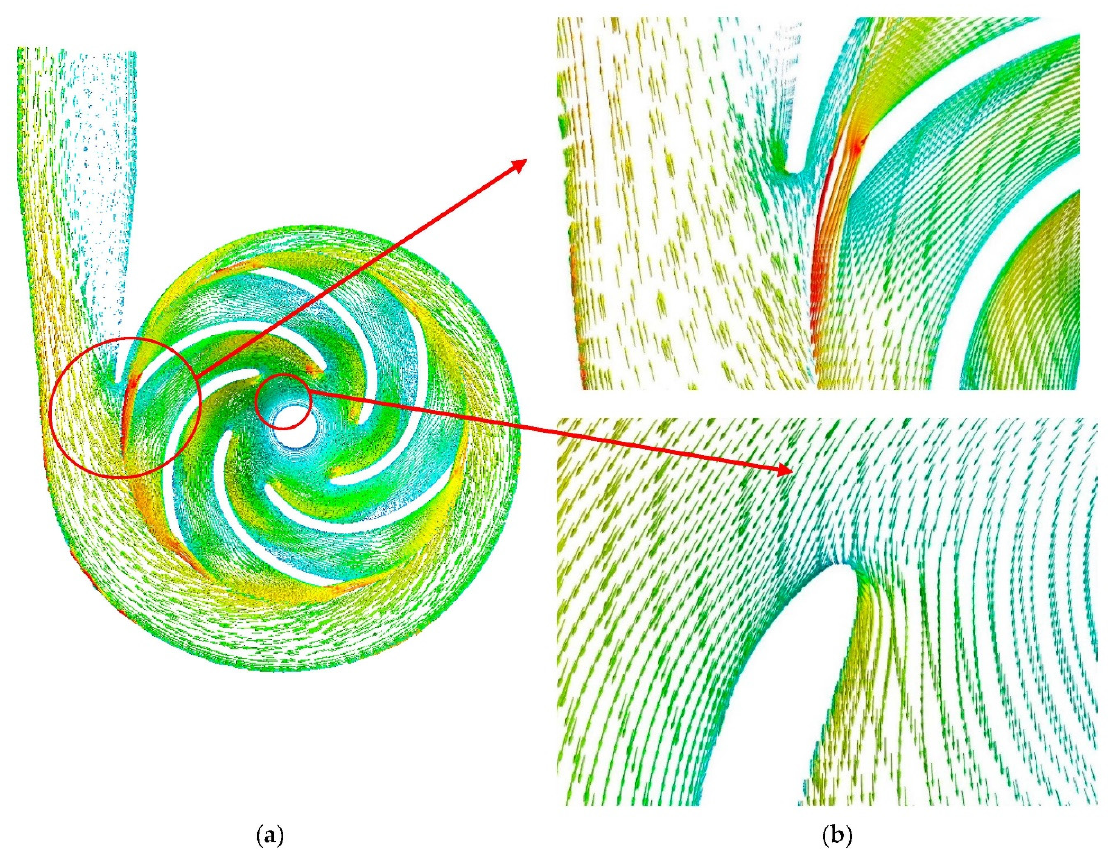
Figure 7. Velocity vectors on a cut plane passing through a 50% span of the blades ( b ) exaggerated views at the leading and trailing edges of the blade at a 50% span.